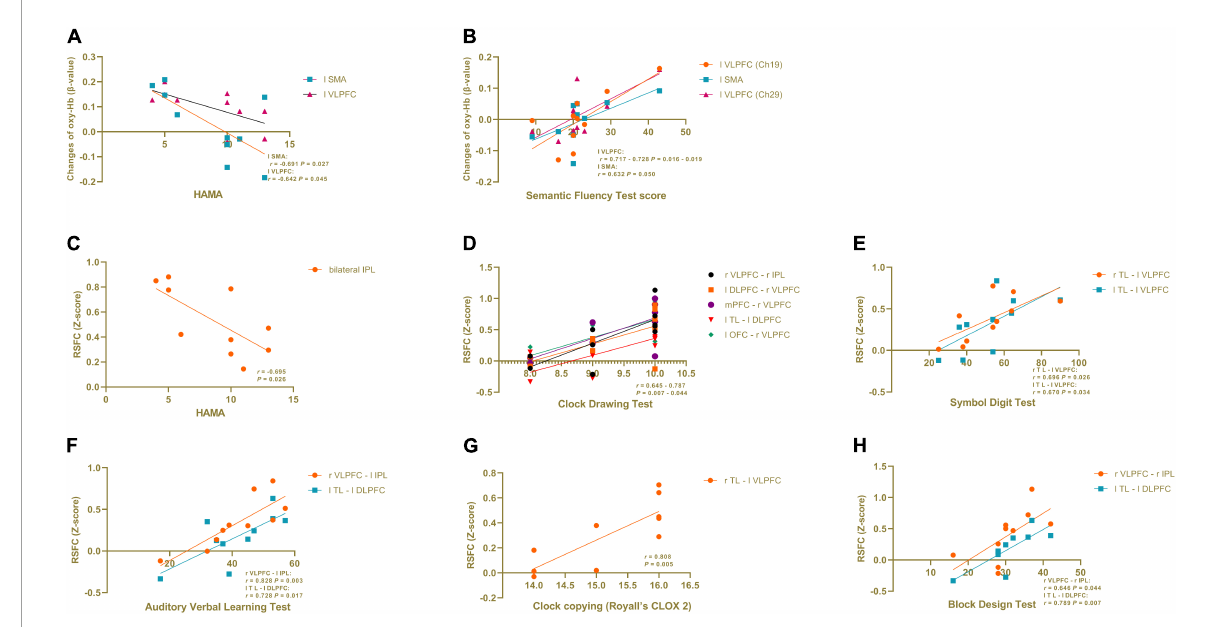
FIGURE4 Correlation analysis in informal PD caregiver between clinical variables and brain activation during VFT and in RSFC. (A) The HAMA score showed a significant negative correlation with the oxy-Hb level ( β -value) in the left SMA and the left VLPFC during VFT. (B) The Semantic Fluency Test score was positively correlated with the oxy-Hb level in the left VLPFC and the left SMA during VFT. (C) The HAMA score showed a significant negative correlation with the RSFC within the bilateral IPL. (D − H) Cognitive domain tests showed a positive correlation with the RSFC between different brain regions. All p <